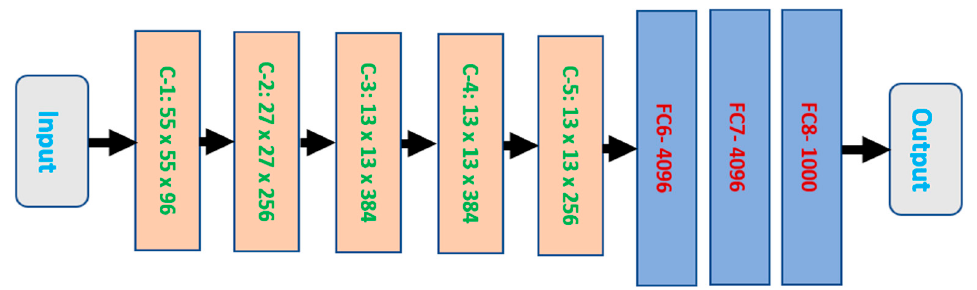
Figure 1. A typical AlexNet structure.